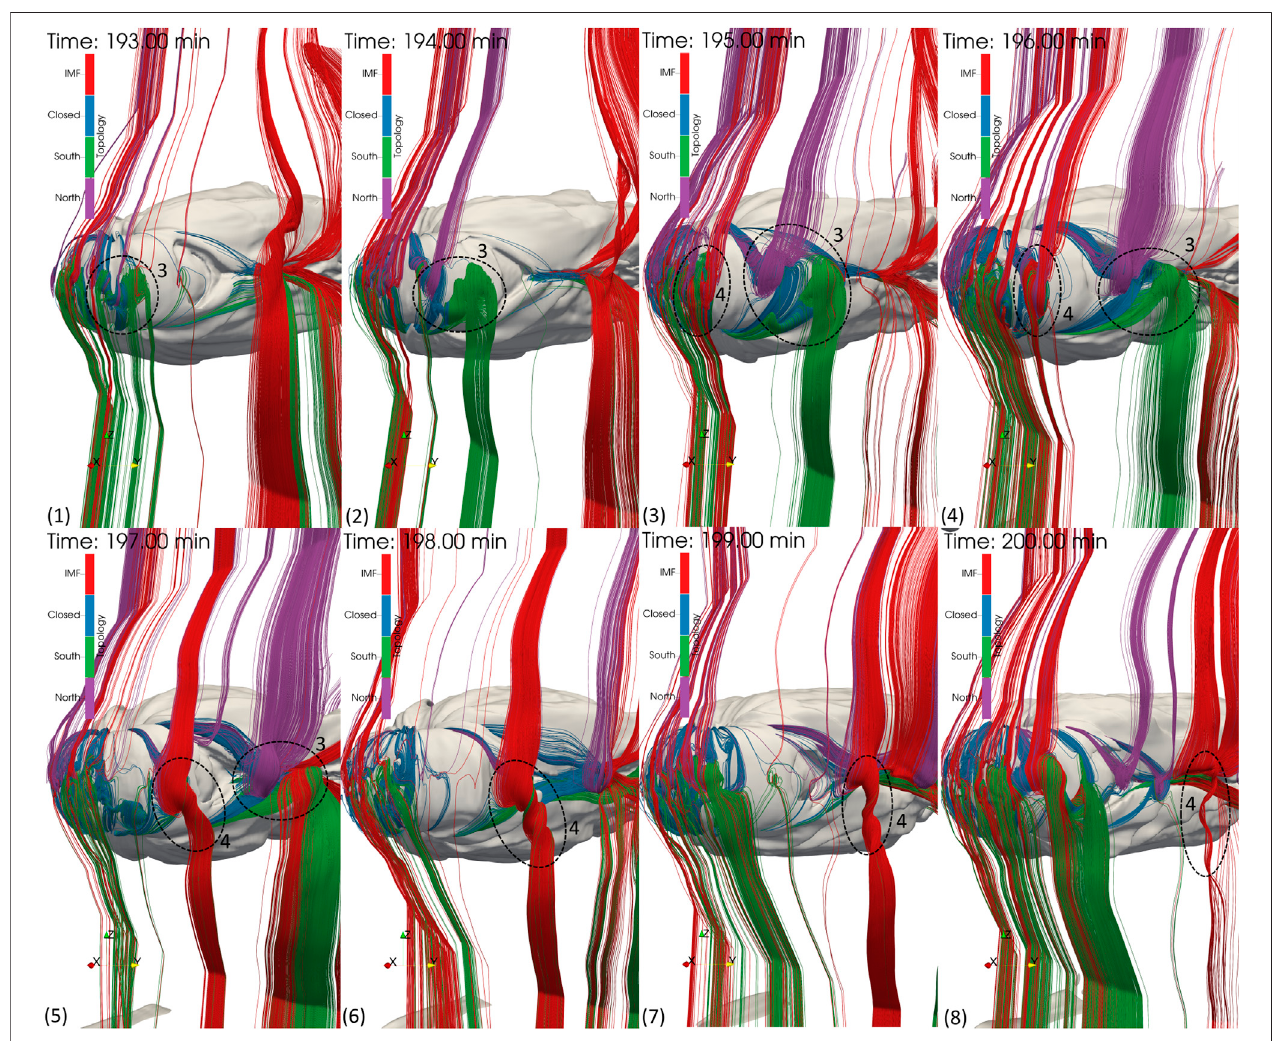
FIGURE 8 | Flux ropes travelling down the dusk fl ank. With each panel, time increases by 1 min. Magnetic fi eld lines are fi ltered by their total rotation, showing only fl ux rope like structures on the magnetopause surface. To fi lter out the inner magnetosphere, a number density contour of 1/ cm 3 is shown. The dayside reconnection region (shown in orange in panel 1), creates a complicated mix of fl ux ropes. Flux ropes three and four are tracked as they propagate down the dusk fl